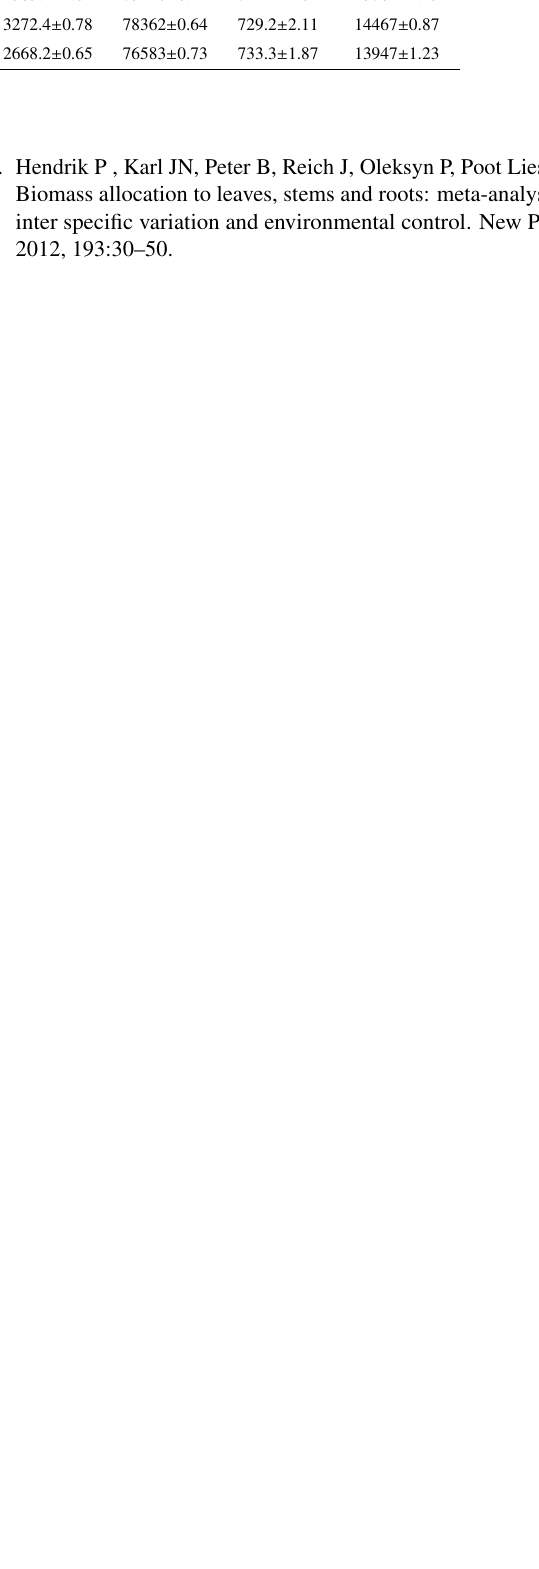
Table 4. E ff ect of decaying macrophytes on minerals concentration under low soil nutrient condition in maize leaves (n = 5). S.No Sample Maize in low nutrient soil Maize in low nutrient soil + Decaying Macrophytes Maize in low nutrient soil + Chemical fertilizer Values are mean of three replications (p ≤ 0.05; LSD